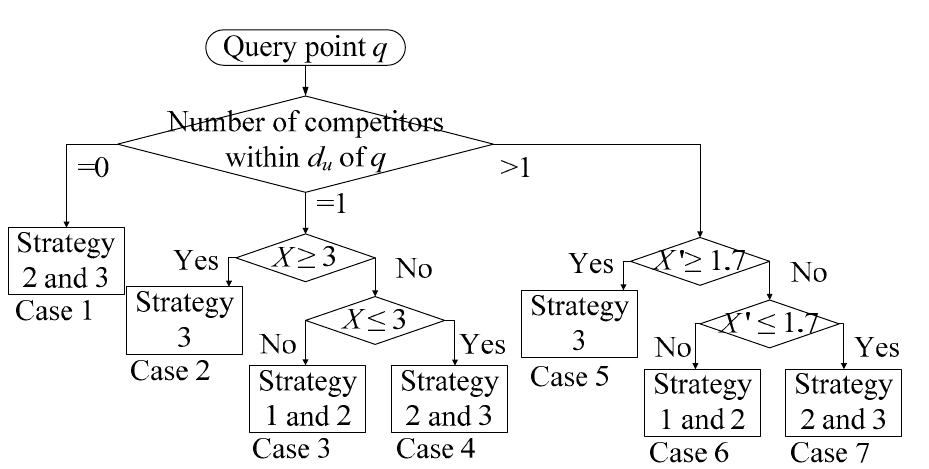
Figure 7. Different competitive scenarios and response strategies.